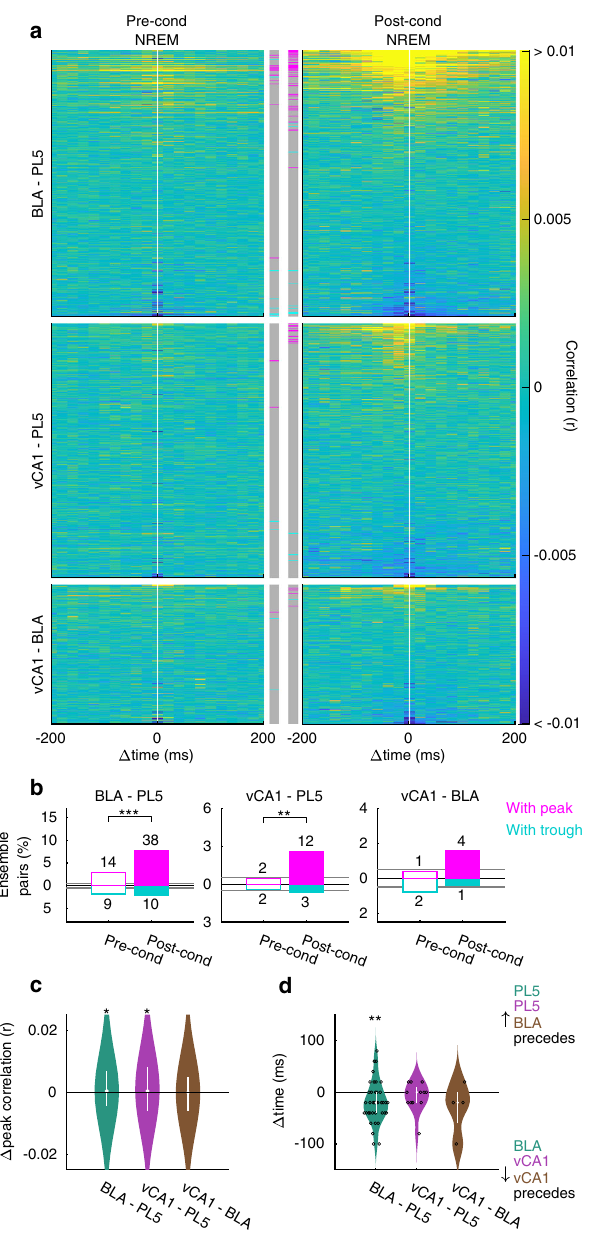
Fig. 3 Memory-encoding ensembles in different brain regions are synchronously reactivated during non-REM sleep after fear conditioning. a Inter-regional CCGs of the instantaneous activation strength of local ensembles, as in Fig. 2d, but for data pooled across rats. b The proportions of ensemble pairs with signi fi cant peaks/troughs among the pairs shown in ( a ). *** p < 0.001, ** p < 0.01, Fisher ’ s exact test. Horizontal bars indicate chance levels (0.5% for each). The number of ensemble pairs is superimposed on each bar. c Violin plots indicating the changes in CCG peak heights from pre- to post-cond NREM for all ensemble pairs that are shown in ( a ). White dots and lines represent median and upper/lower quartiles, respectively. * p < 0.05, WSR-test. d Violin plots of peak time on the CCGs of coupled-ensemble-pairs. White dots and lines represent median and upper/lower quartiles, respectively. ** p < 0.01, WSR-test. Open circles indicate individual data points (small horizontal jitters are added for visualisation). The numbers of tested pairs and those in each rat are summarised in Supplementary Table 4. In addition, detailed statistics are shown in Supplementary Data 1. Source data are provided as a Source Data fi